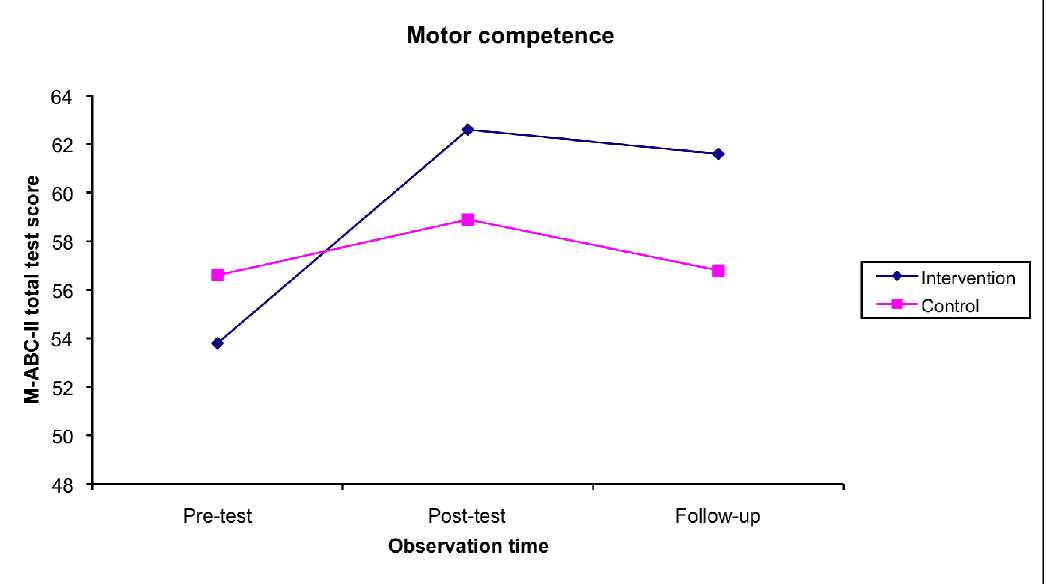
Mean total test scores of the M-ABC-II for both intervention and control group with AS (n